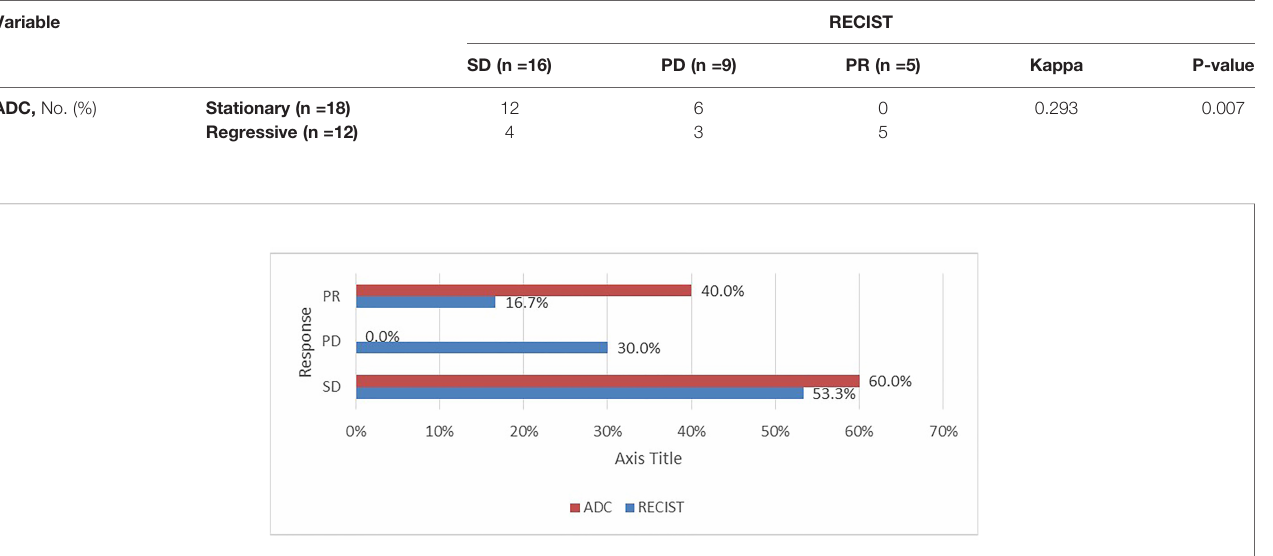
FIGURE 3 | Distribution of response according to ADC and RECIST.